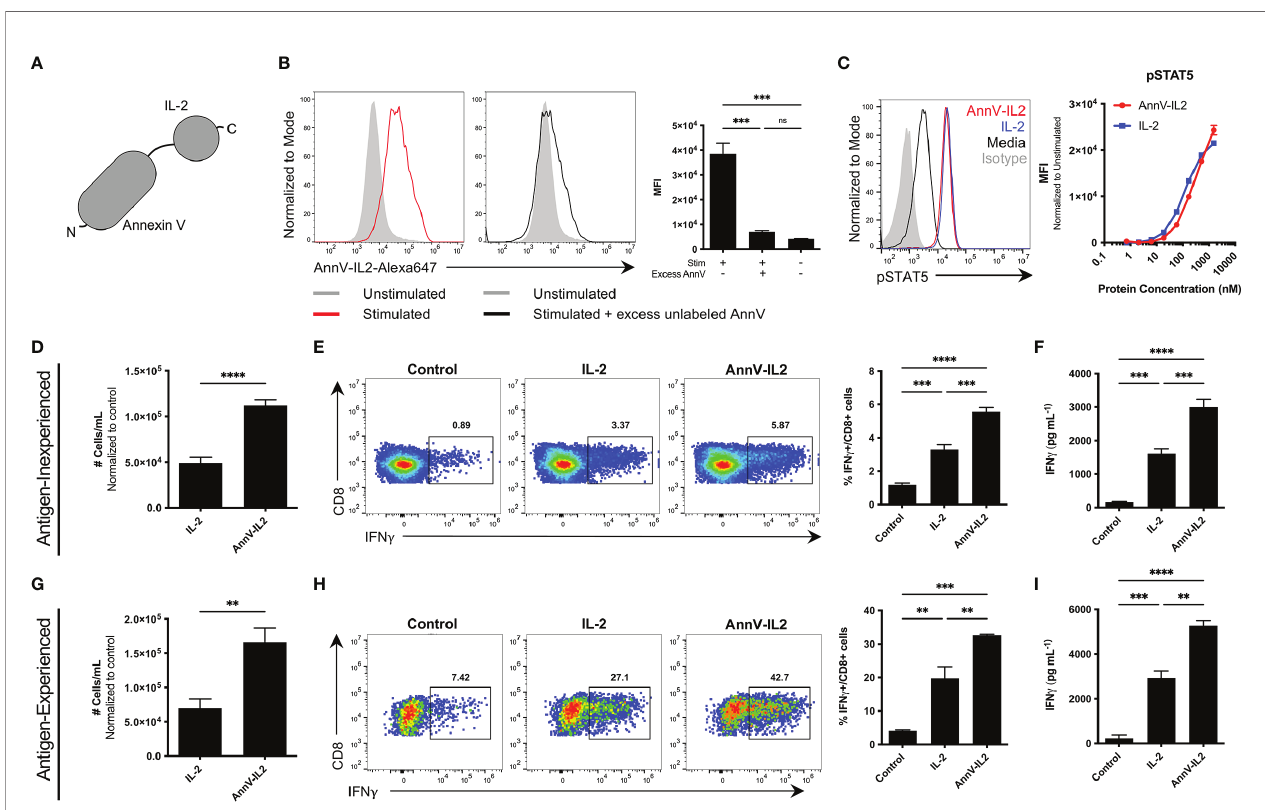
FIGURE 2 | Comparison of the function of AnnV-IL2 and IL-2 in vitro . (A) Schematic of AnnV-IL2 construct. (B) Antigen experienced OT-1 cells were stimulated with anti-CD3 and anti-CD28 antibodies or left unstimulated for 5 hours. Cells were then pre-treated with or without excess unlabeled AnnV prepared in annexin V binding buffer for 30 minutes. Cells were washed and then stained with Alexa-647 labeled AnnV-IL2 or IL-2 protein. Histograms represent one sample from each group. (C) CTLL2 cells were IL-2 starved for 5 hours and then stimulated with the indicated concentration of AnnV-IL2 or IL-2 for 10 minutes and then immediately fi xed. Cells were permeabilized and stained intracellularly with anti-pSTAT5 or isotype antibodies. (D) Antigen inexperienced or (G) antigen experienced CD8+ cells were cultured with anti-CD3 and anti-CD28 antibodies for 24 hours. After 24 hours, media was removed and replaced with media containing anti-CD28 with or without equimolar amounts of AnnV-IL2 or IL-2 and incubated for 5-6 days. Absolute cell counts were determined using a fl ow cytometer. (E) Antigen inexperienced or (H) antigen experienced CD8+ T cells were cultured with anti-CD3 and anti-CD28 in the presence of equimolar amounts of AnnV-IL2 or IL-2 for 3 days. Brefeldin A was added to culture media on day 3 and IFN g production was quanti fi ed by intracellular fl ow cytometry. ELISA for IFN g in supernatant of (F) antigen inexperienced or (I) antigen experienced cell cultures. (D – I) Control refers to cells stimulated with only anti-CD3 and anti-CD28. Data is represented by mean ± SEM. P values were calculated by ordinary one-way ANOVA with the Tukey-Kramer multiple comparison test, and P < 0.05 is considered statistically signi fi cant. ** = < 0.01,*** = < 0.001, **** = < 0.0001. AnnV, Annexin V; MFI, Median fl uorescent intensity. NS, not signi fi